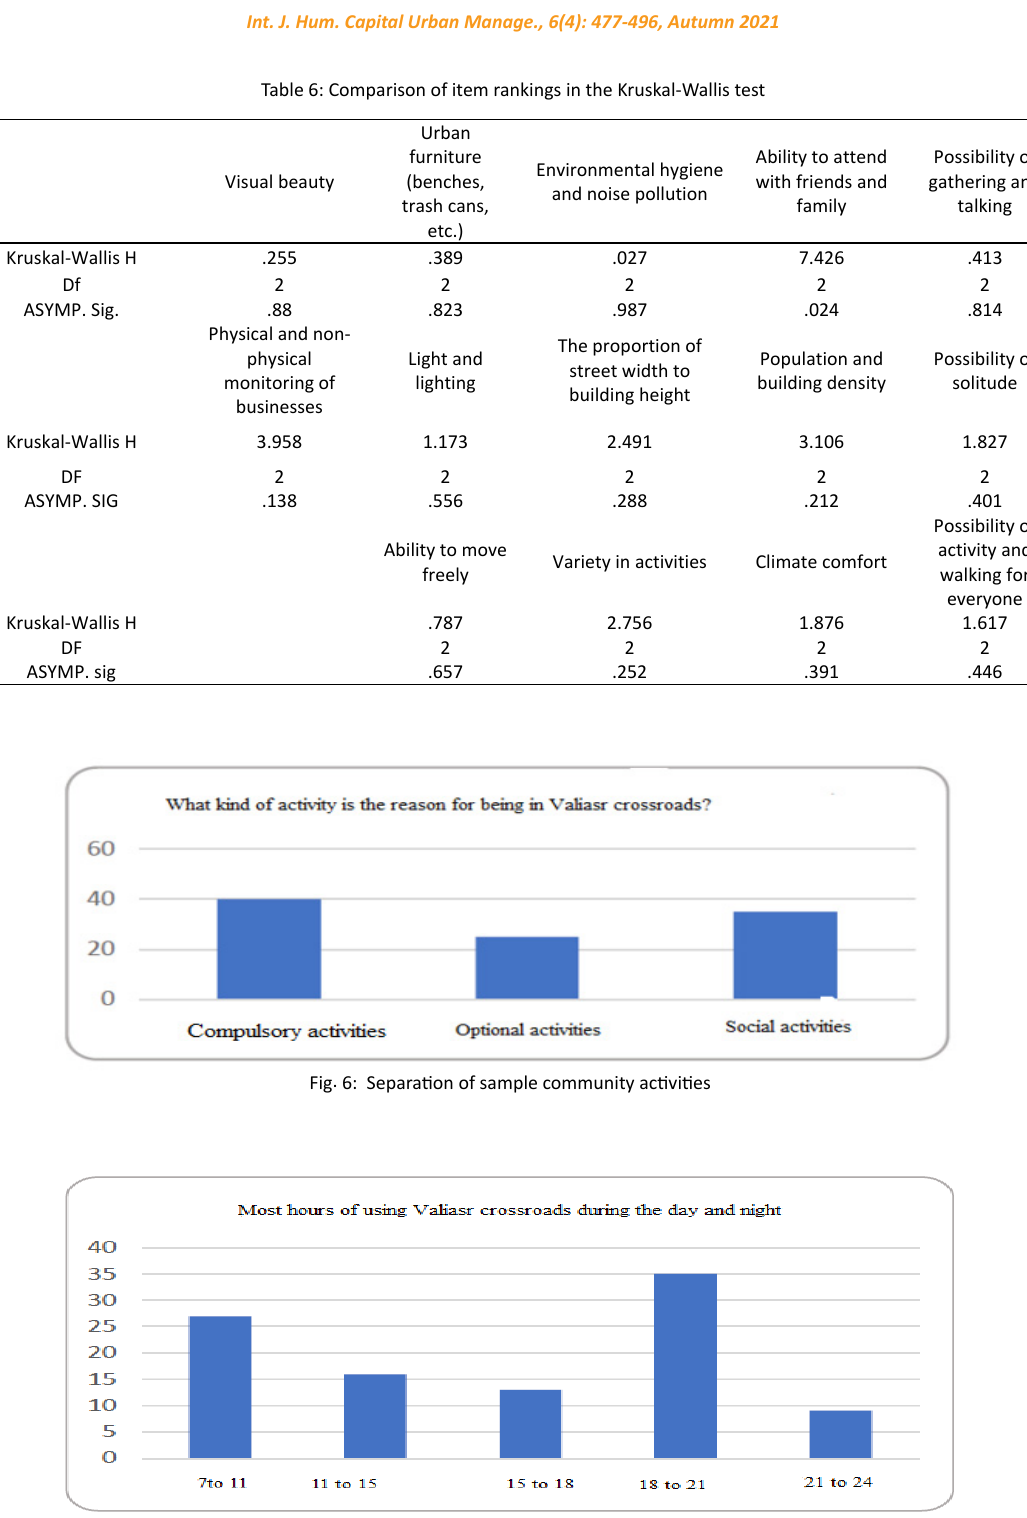
Fig . 7: Hours of community use of sample Fig. 7: Hours of community use of sample space